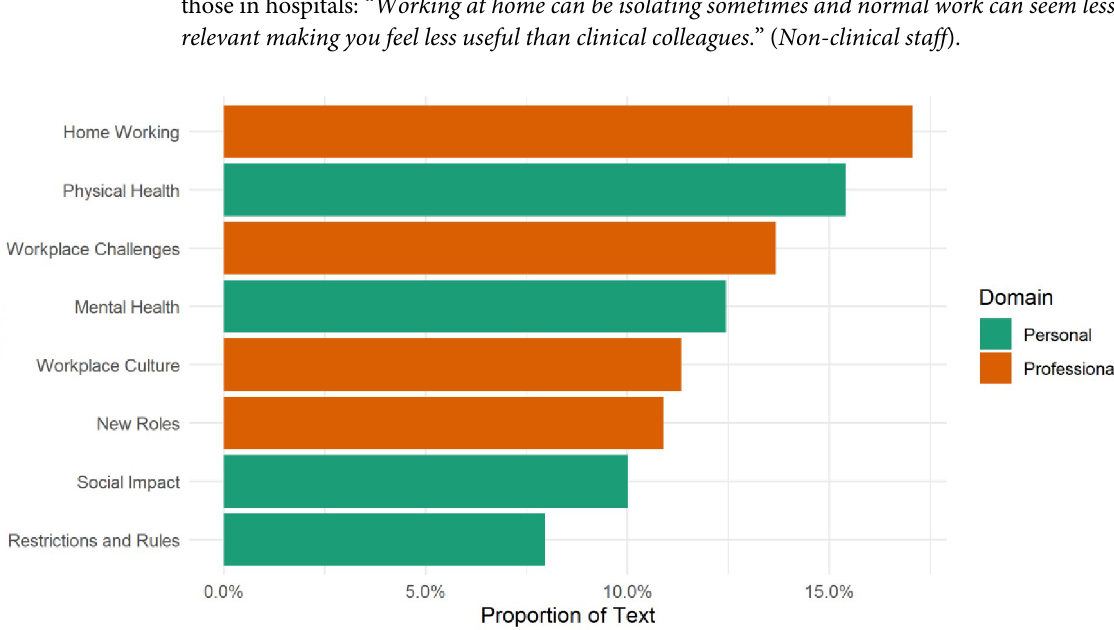
Fig 1. Proportion of text devoted to each theme. Source: Drawn by the authors from data analysed for this paper.